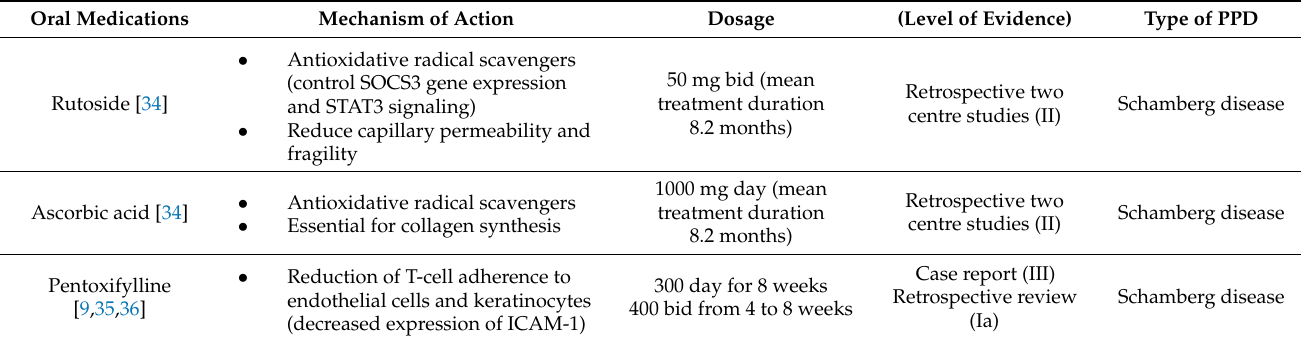
Table 3. Oral therapies used for treatment of pigmented purpuric